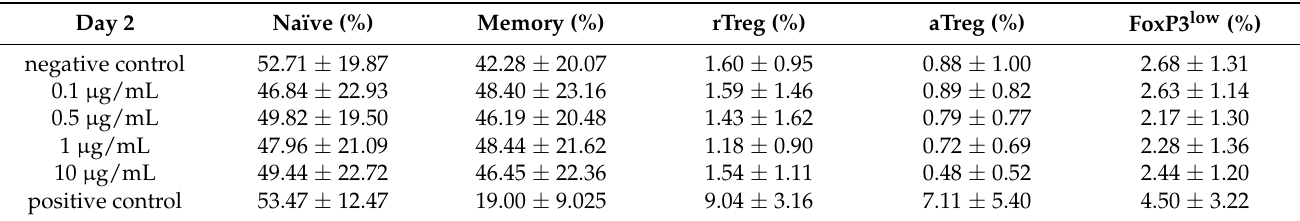
Table 3. Variation in CD4 + subpopulations after incubation with ZnO-NP in different concentrations for 48 h. There were no significant differences in the statistical evaluation. Data represent the mean +/ − standard deviation (n = 9).